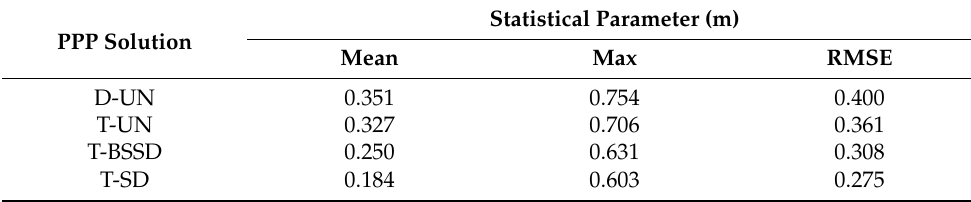
Table 4. Statistical parameters of 3D position accuracy for different kinematic PPP